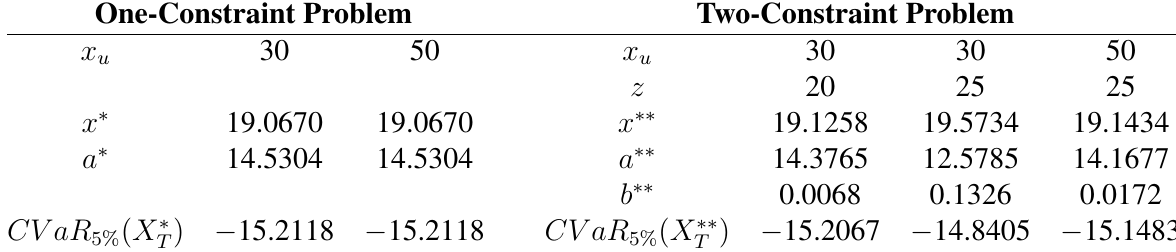
Black–Scholes example for one-constraint (pure CVaR minimization) and two-constraint (mean-CVaR optimization) problems with parameters: r = 5% , µ = 0 . 2 , σ = 0 . 1 , S = 10 , T = 2 , x = 10 , x = 0 , λ = 5% . Consequently, z ∗ = 18 . 8742 and 0 0 d ¯ z = 28 . 8866